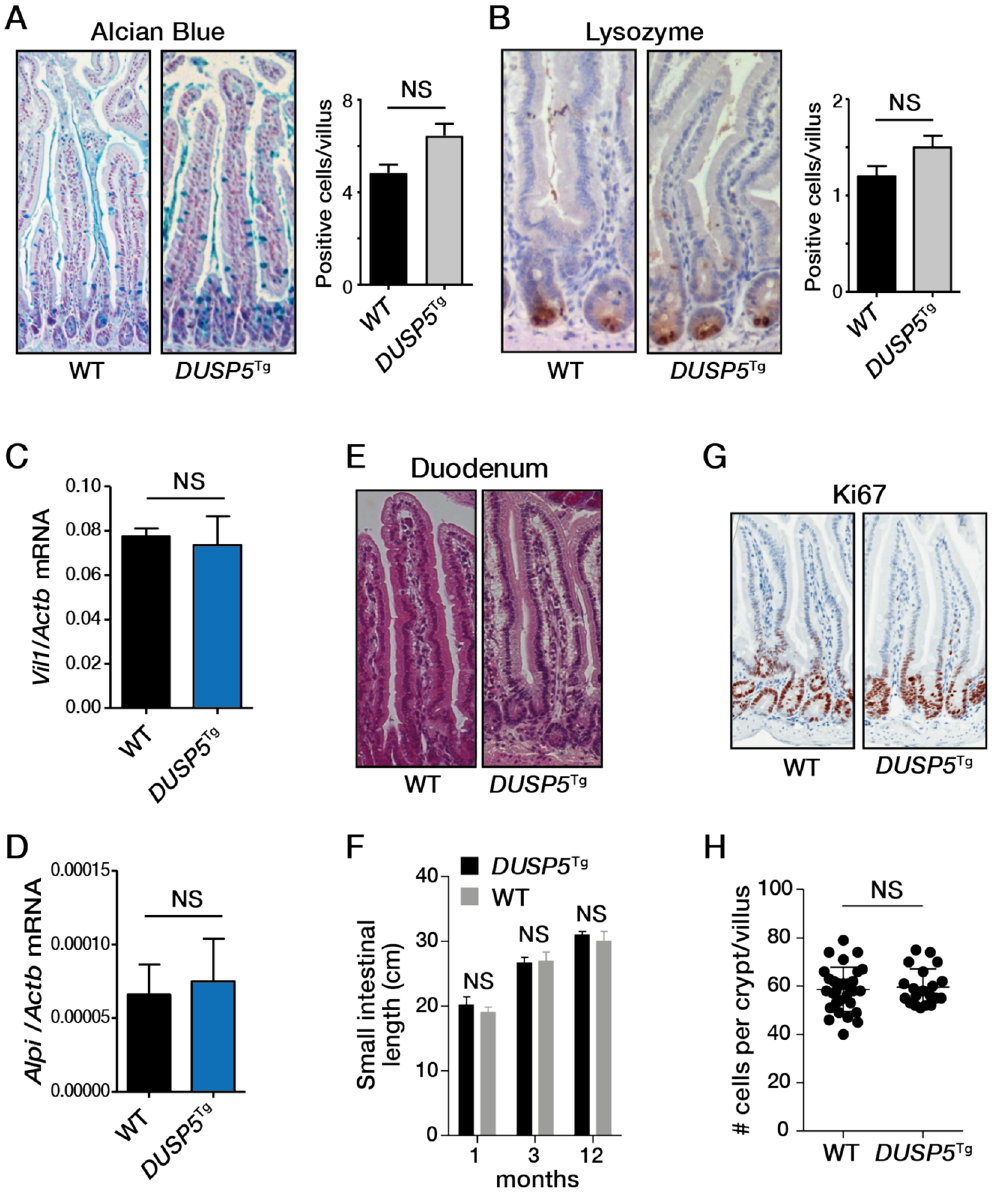
Figure 7. Impact of DUSP5 overexpression on intestinal phenotype. Effect of DUSP5 overexpression on cell differentiation as determined by staining for ( A ) Goblet cell (Alcian Blue) and ( B ) Paneth cell (lysozyme) markers, and measuring mRNA levels of ( C ) villin ( Vil1 ) and ( D ) alkaline phosphatase ( Alpi ). Effect of DUSP5 overexpression on ( E,F ) small intestinal length, ( G ) cell proliferation and ( H ) crypt cell number (10 crypts per mouse; 3 mice per